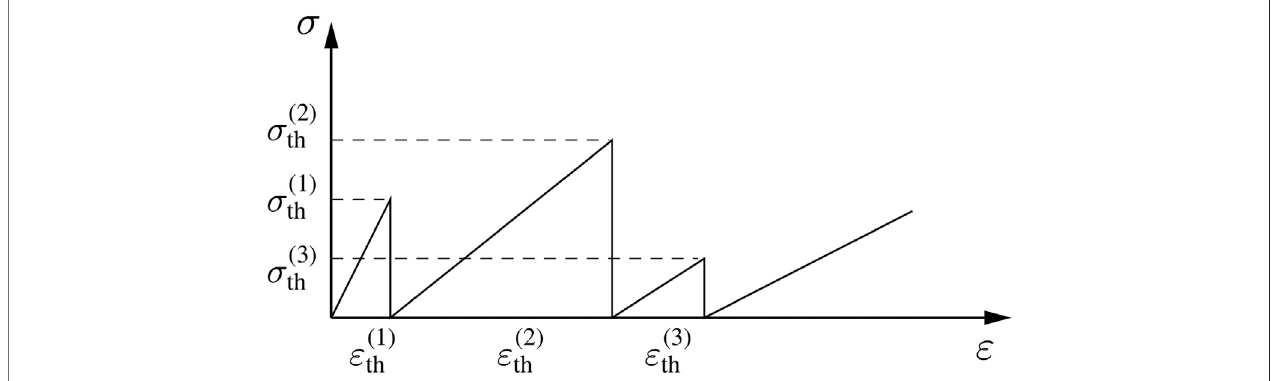
FIGURE 8 | Constitutive behavior of a single fi ber with annealed disorder of the slip thresholds. The value of the stiffness parameter is a (cid:1) 0 . 8 so that the fi ber stiffness gradually decreases (compare to Figure 1 ). The consecutive thresholds σ ( k ) th are drawn from the same probability distribution p ( σ th ) , then the corresponding strain thresholds ε ( k ) th are obtained from Eq. 24 .